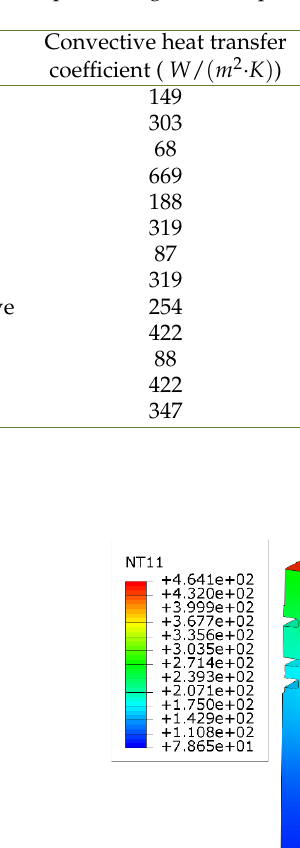
Table 3. Thermal boundary conditions of piston ring area and piston skirt